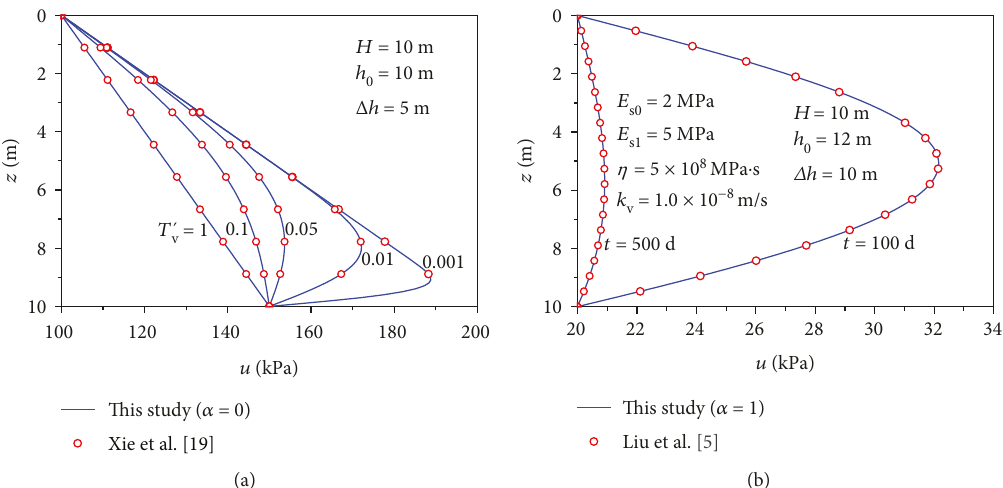
Figure 2: Comparison of pore-water pressure calculated by the semianalytical solution and the available analytical solutions. (a) Linear elastic model. (b) Standard Merchant